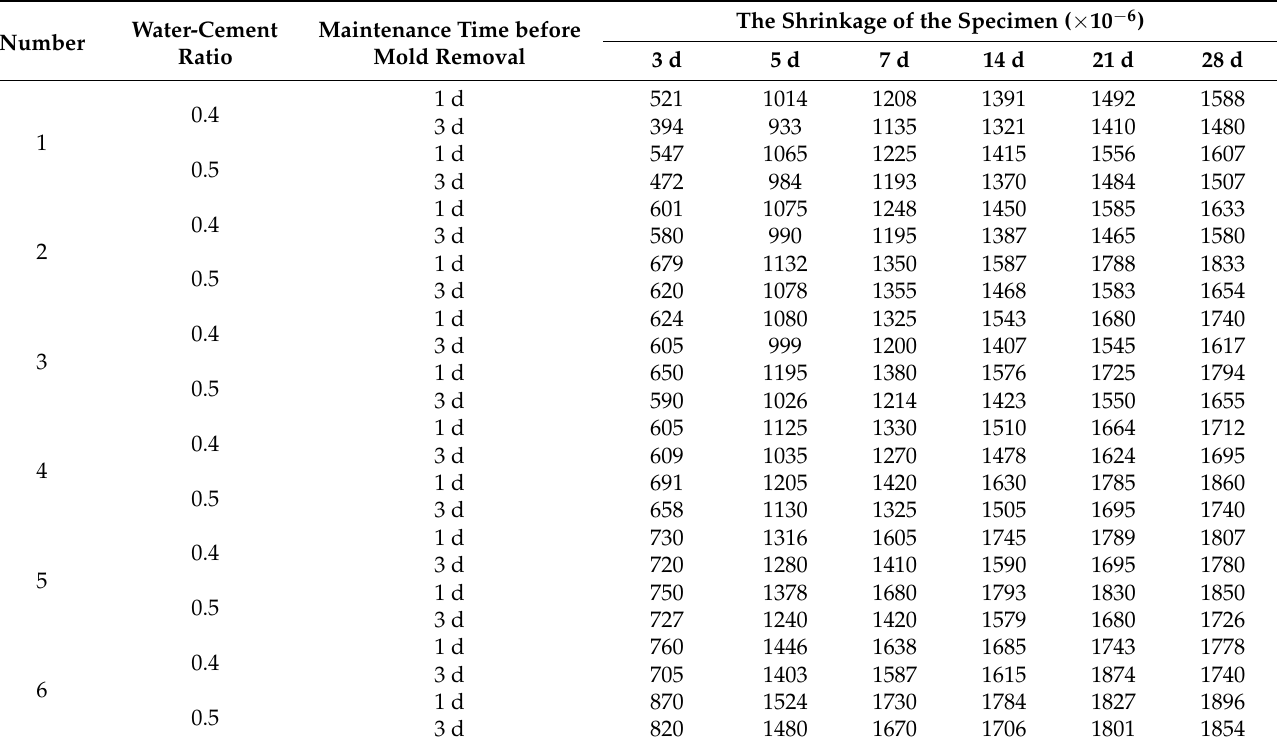
Table 4. Dry shrinkage of foamed concrete in different environments.